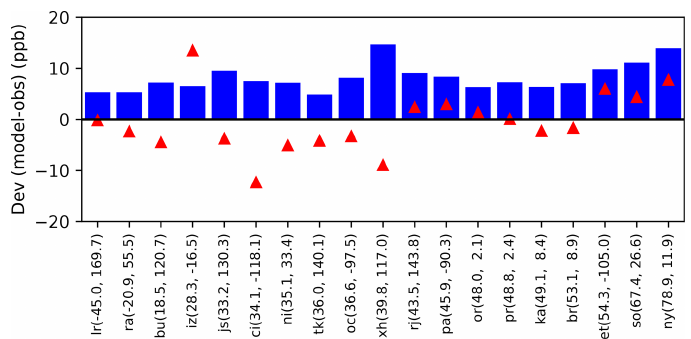
Figure C1. Statistical comparison of the GEOS-Chem a posteriori methane distribution and TCCON XCH 4 data (v GGG2020) in 2019 and 2020. Red upward triangles denote the mean bias and the blue bars denote the corresponding 1s values.